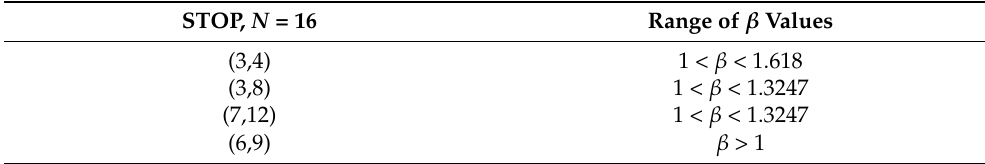
Table 2. Range of β values when N =